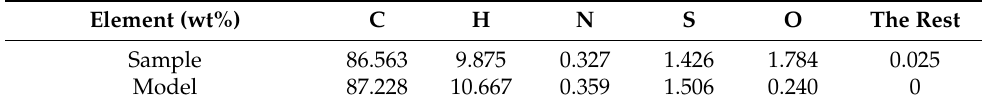
Table 2. Comparison of elemental content of asphalt samples and